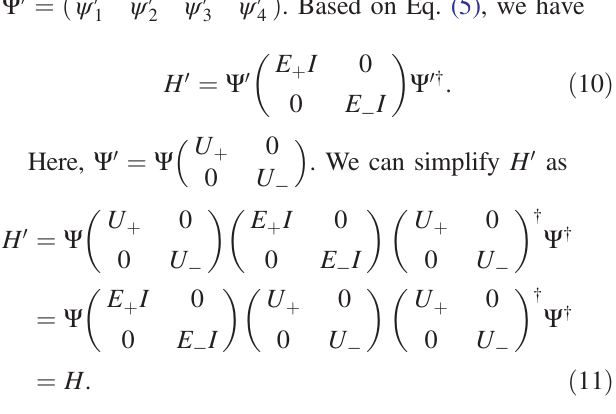
FIG. 2. Effective velocity v and intervalley scattering strength m are plotted as a function of the geometric factor γ . The calculated results on velocity v (in units of v ) are shown as black F solid squares, and those for m (in units of t ) are shown as red open circles. These parameters are obtained for a fixed periodicity L ¼ 13 nm. The dashed curves are linear